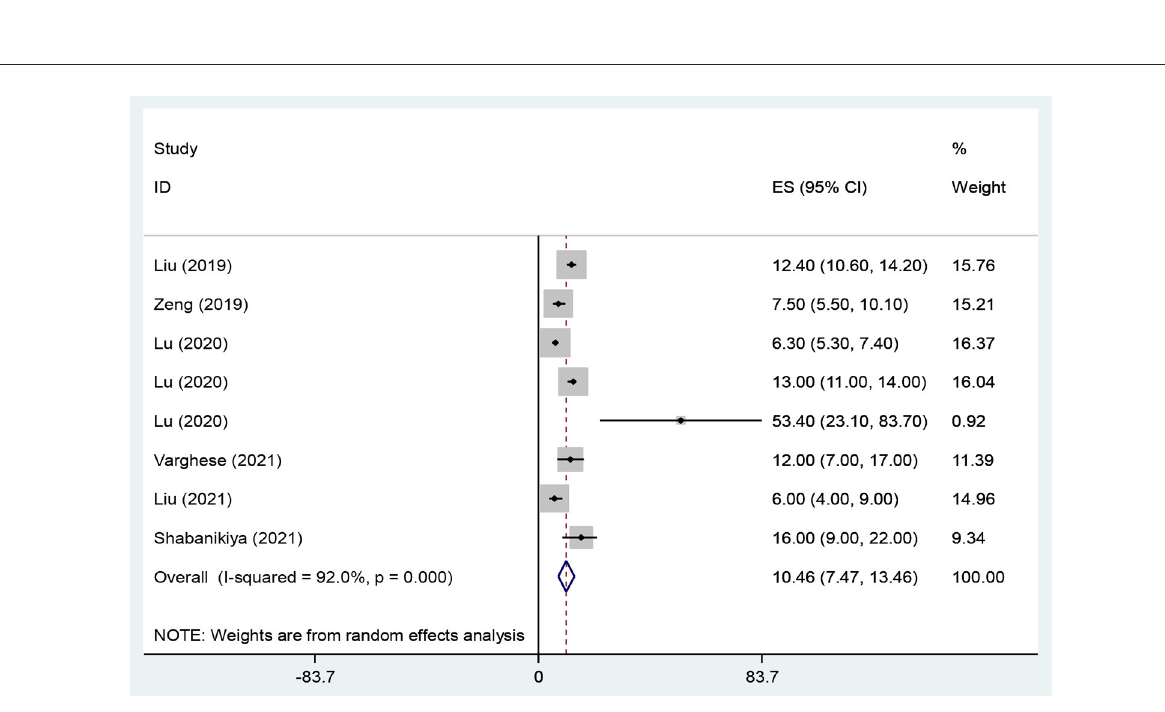
FIGURE5 The Forest plot of overall and individual prevalence of sexual harassment with 95% confidence